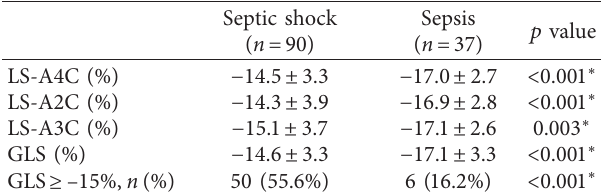
Table 3: Strain echocardiographic